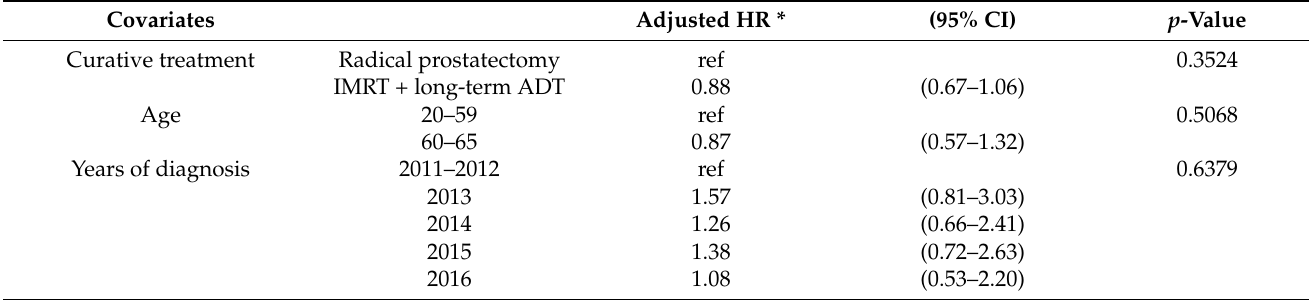
Table 4. Multivariate Cox proportional hazards regression analysis of locoregional recurrence in young patients with high- to very high-risk prostate